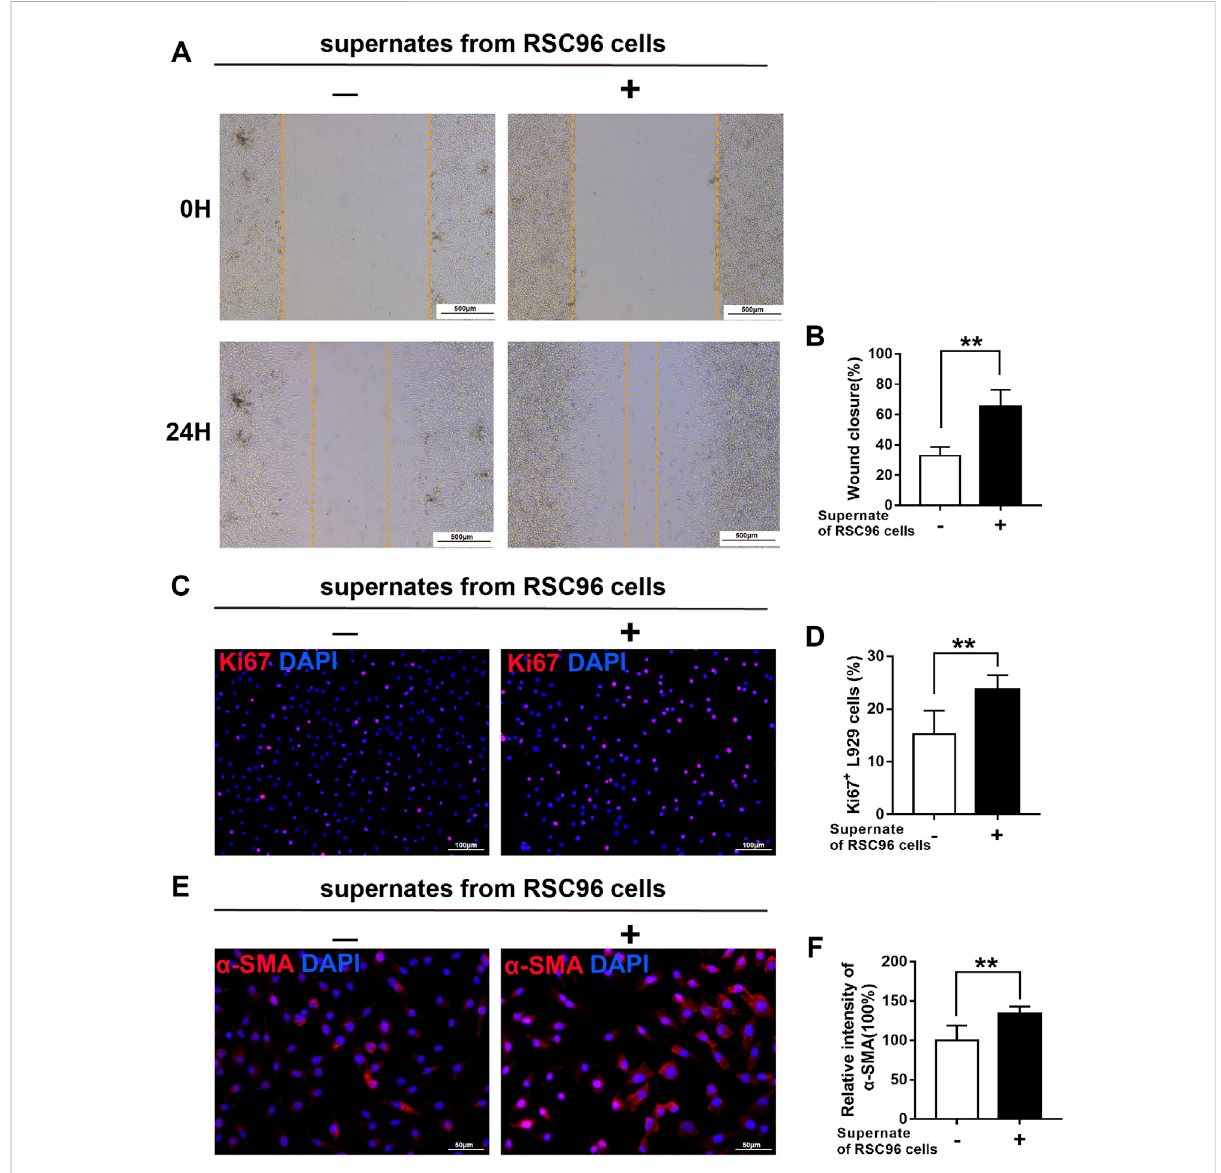
FIGURE 8 SCshaveaparacrineeffecton fi broblastsundernormalglucoseconditions. (A,B) AscratchassayofL929 fi broblastsculturedin5.5 mMglucose and treated for 0 or 24 h with (+) or without ( − ) supernates from RSC96 cells cultured under the same glucose conditions. Representative immuno fl uorescence analyses of Ki67 (C) and α -SMA (E) , and the numbers of Ki67 + cells (D) and intensity of α -SMA immunoreactivity (F) , in L929 fi broblasts cultured and treated as described for (A,B) . Data are presented as mean ± SD of three independent experiments, ** p < .01, Student ’ s t